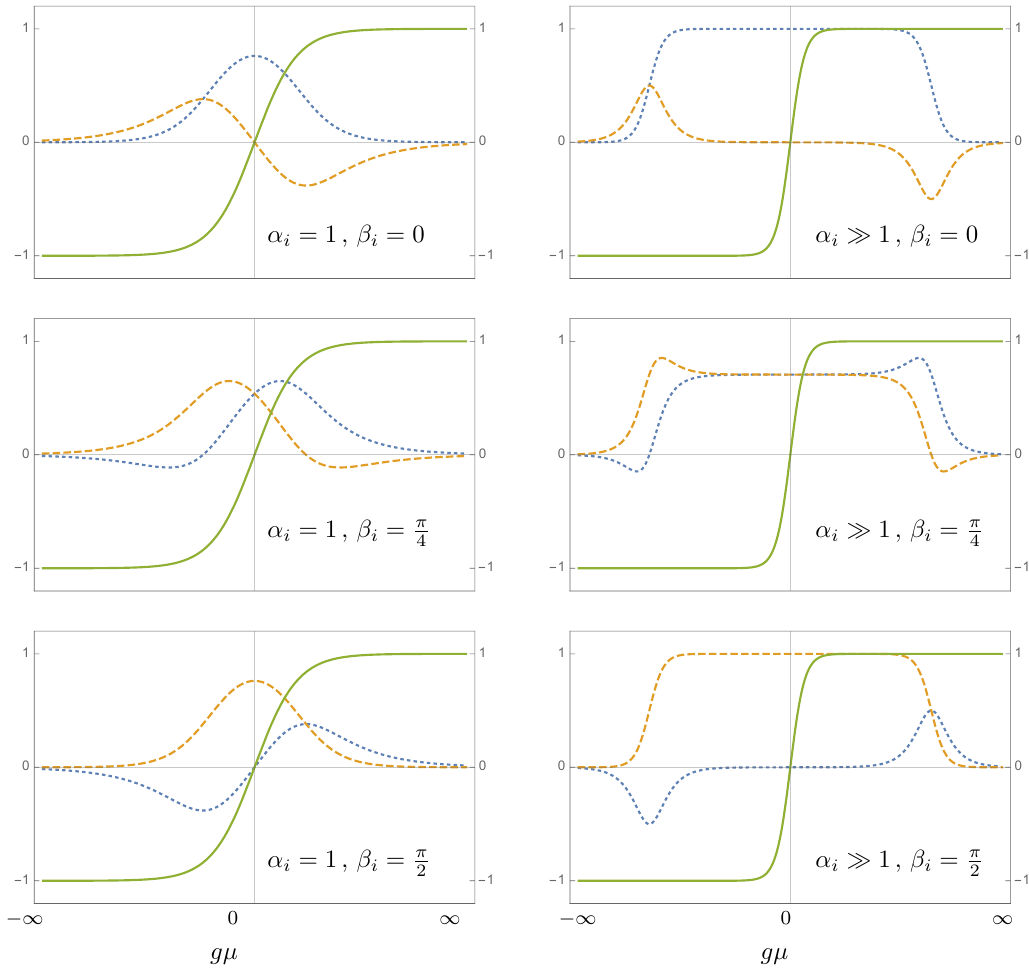
Figure 2 . Plots of Re ˜ z i (blue dotted line), Im ˜ z i (orange dashed line) and A 0 ( µ ) (green solid line) as a function of the radial coordinate gµ ∈ ( −∞ , ∞ ) for different values of the Janus parameters ( α i , β i ) . The limit α i (cid:29) 1 (i.e. tanh α i ≈ 1 ) renders the Janus solution singular. In this limit, ˜ z i gets to the boundary of the moduli space which is located at | ˜ z i | = 1 in the unit-disk parameterisation of